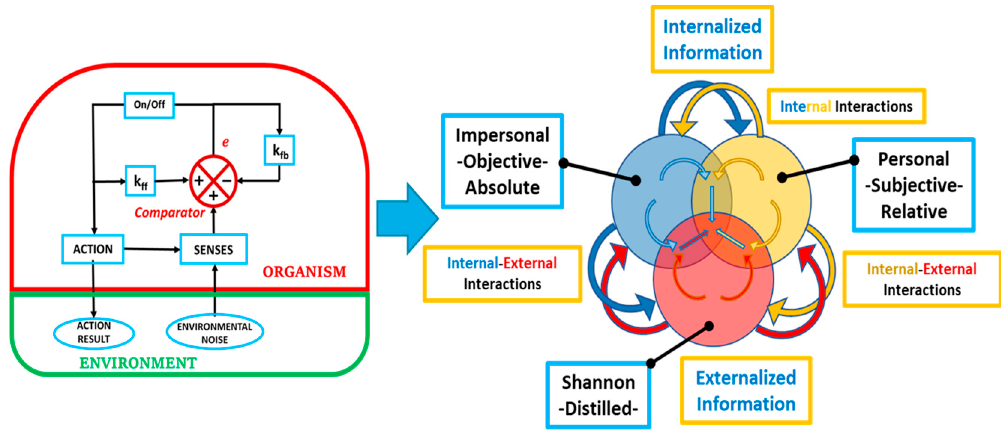
Figure 2. The process of info-autopoiesis.